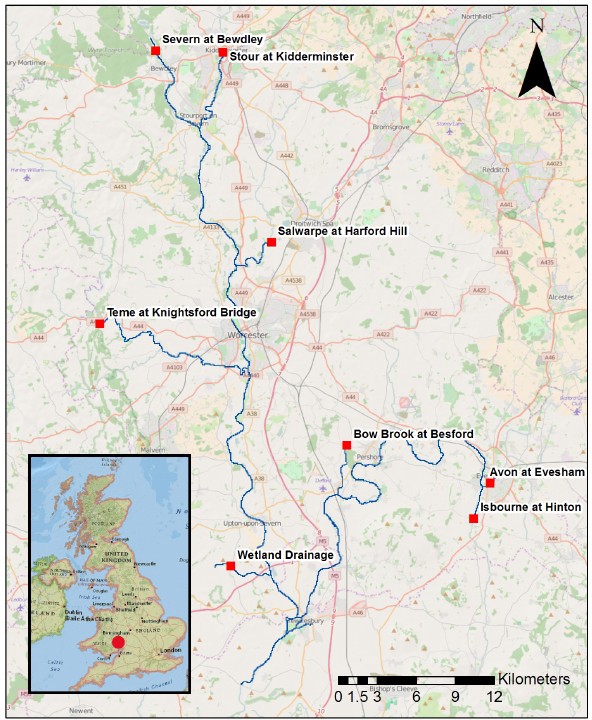
Figure 2. Extent of the River Severn